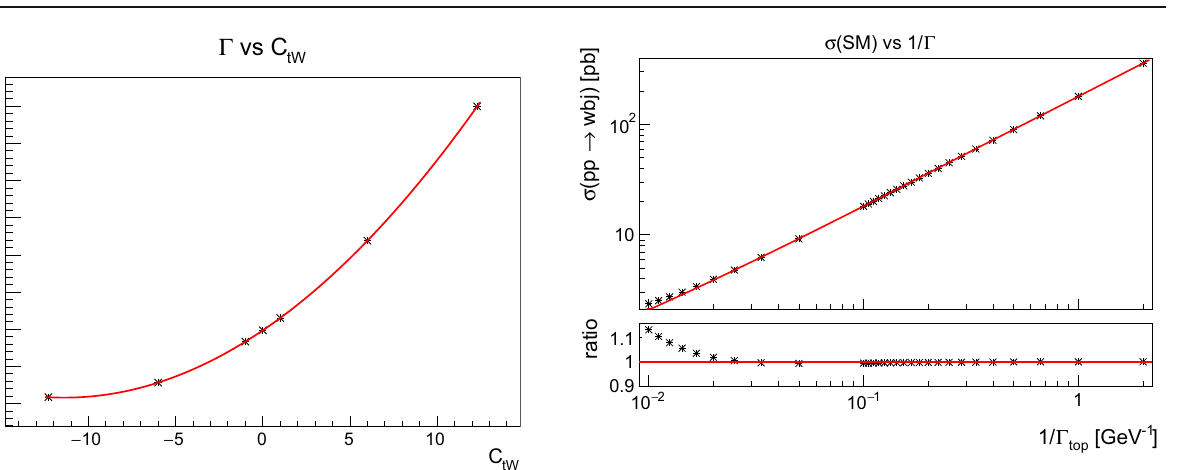
Fig. 6 The SM cross section as a function of the width of the top. The Fig. 5 The top width as a function of the effective coupling C tW for NWA is valid when the relation is (cid:3) = 1 TeV. The quadratic dependence on C tW is predicted by Eq. 3.5. At the indicated points the width is computed for the corresponding C tW values, while the line is a quadratic fit